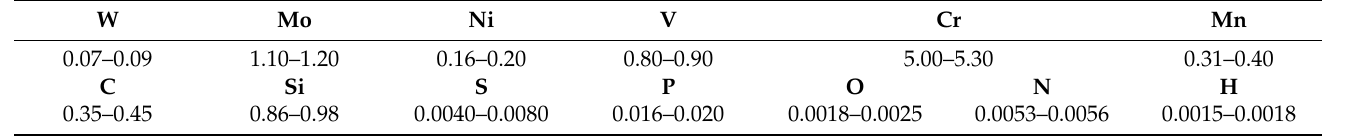
Table 1. Chemical composition range of H13 grade steel scrap used